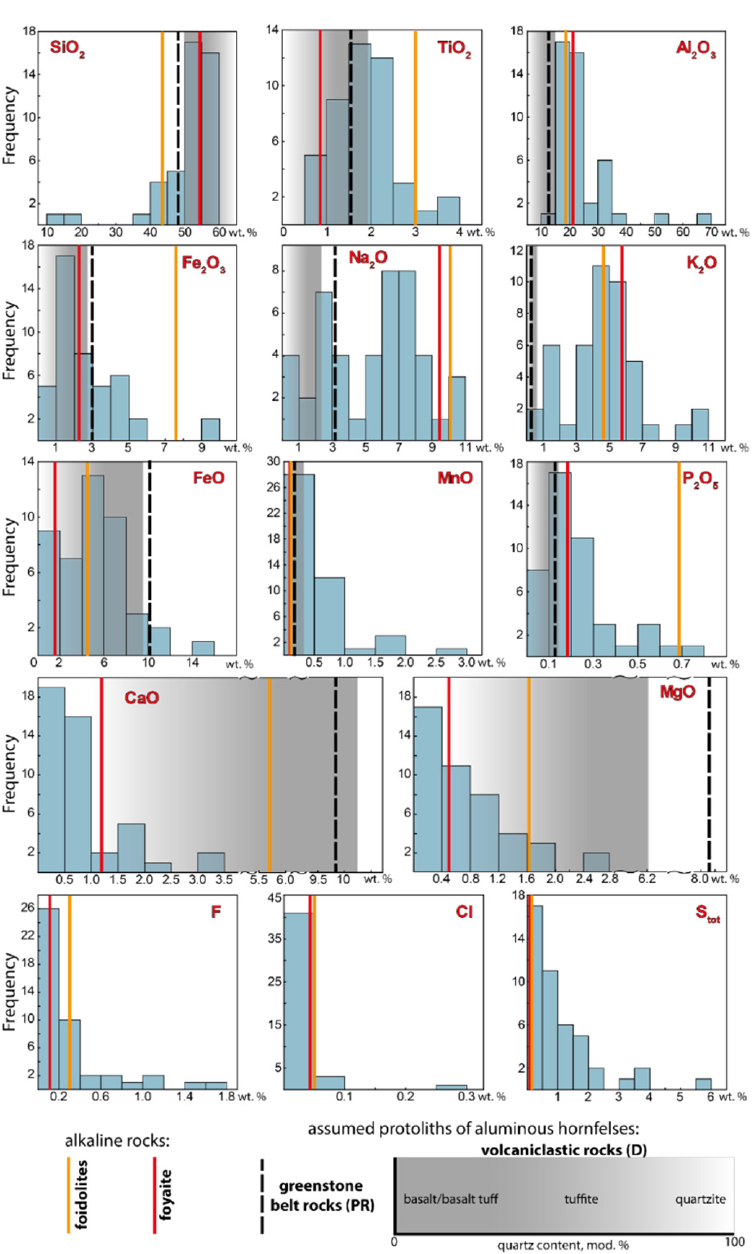
Figure 11. Comparison of the chemical compositions of aluminous hornfelses, volcanoclastic rocks, greenstone belt rocks, and alkaline rocks, namely foyaite and foidolites (Khibiny massif). The compositions of aluminous hornfelses are presented as bar diagrams, and the compositions of volcaniclastic rocks [32] are shown as gradients. Red and yellow lines show the average composition of foyaite and foidolites [42], respectively. Dotted lines show the composition of greenstone rocks near the contact with the Khibiny massif according to